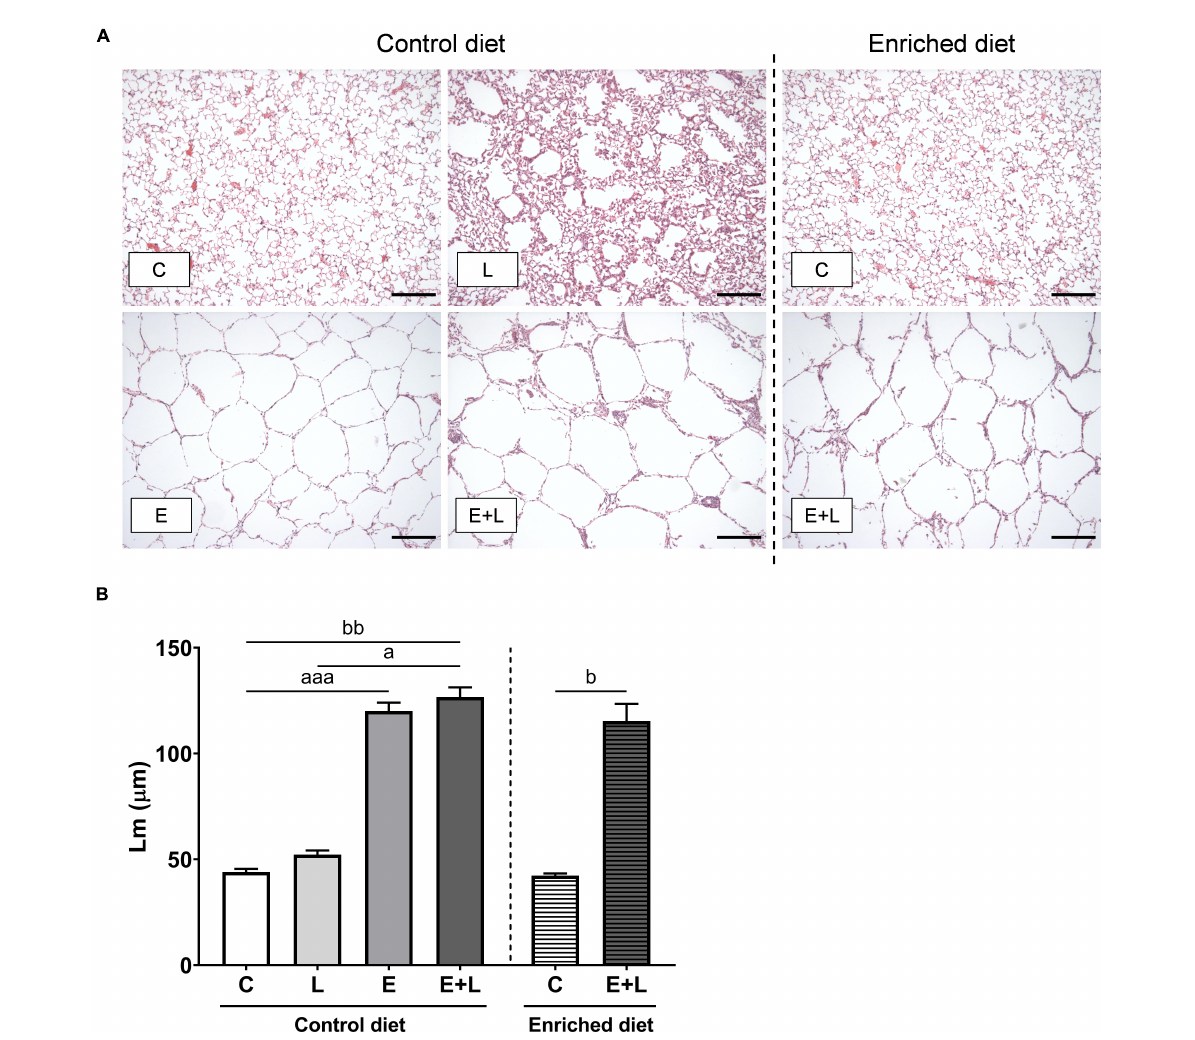
FIGURE2 Emphysema assessment in lung histological sections. (A) Representative photomicrographs of H&E-stained lung sections for each study group (scale bar: 100 µ m; 100 × magnification). (B) Lm analysis on H&E-stained lung sections. Data are presented as mean ( µ m) ± SEM. a p < 0.05; aaa p < 0.001 (first analysis for elastase and/or LPS effects). b p < 0.05; bb p < 0.01 (second analysis for diet and/or E + L effects). C = control (control diet: n = 7; enriched diet: n = 7); L = LPS ( n = 7); E = elastase ( n = 8); E + L = elastase plus LPS (control diet: n = 9; enriched diet: n =